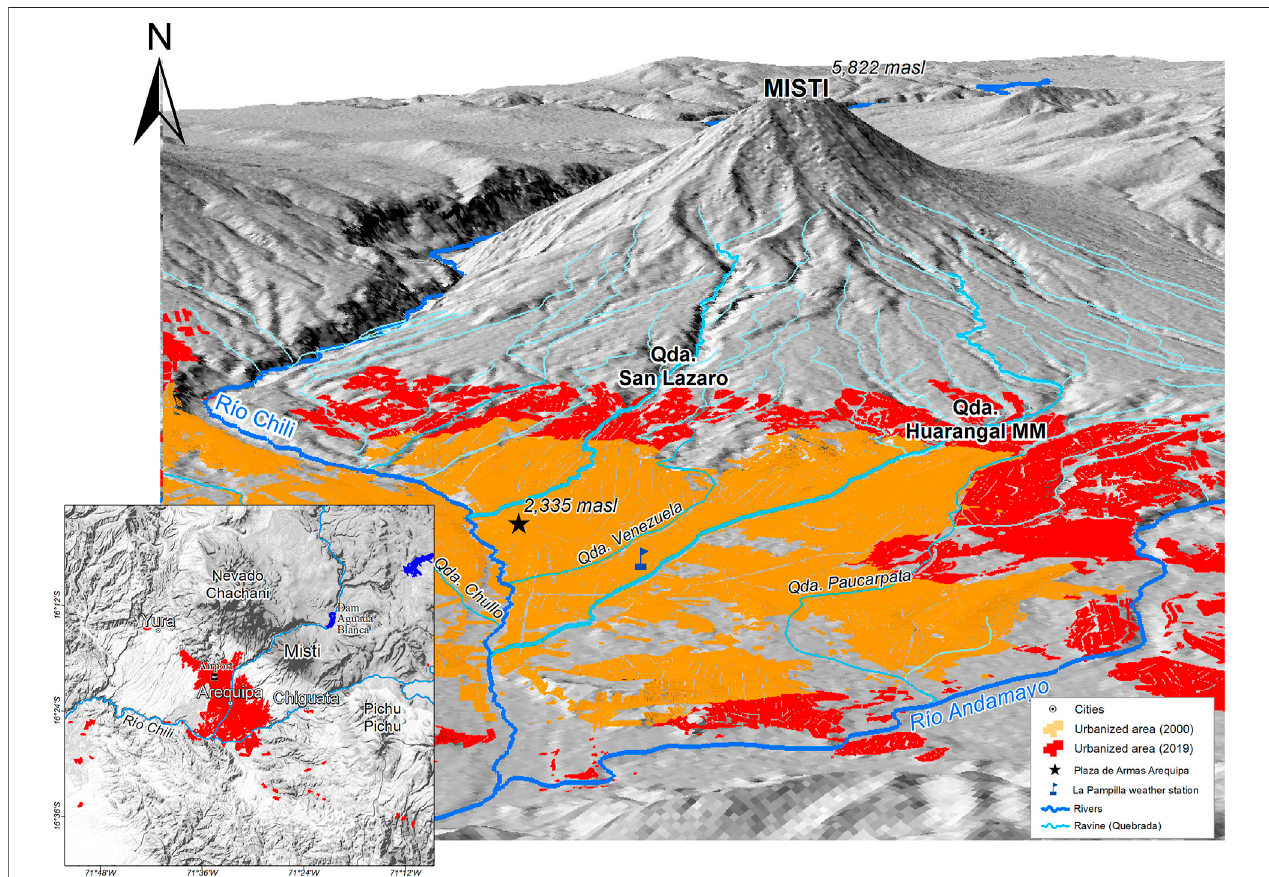
FIGURE 1 | Peripheral growth of the city of Arequipa over the past 20 years. Construction has spread out from the initial oasis and Historic center on the east Río Chili high terrace (1540 – 1940) onto the volcaniclastic fans SW of El Misti after 1960 and encroached the slopes of the volcano as well as the volcaniclastic apron of Nevado Chachani after 1980. Drainage network including tributaries (locally termed quebradas or torrenteras) to the main artery, Río Chili. Quebrada San Lazaro and Quebrada Huarangal – Mariano Melgar (Huarangal-MM) are the targets of this study. The meteorological station La Pampilla is indicated. Inset map shows the setting of the city of Arequipa, basin, and neighboring volcanoes (active El Misti, dormant Chachani, and extinct Pichu).